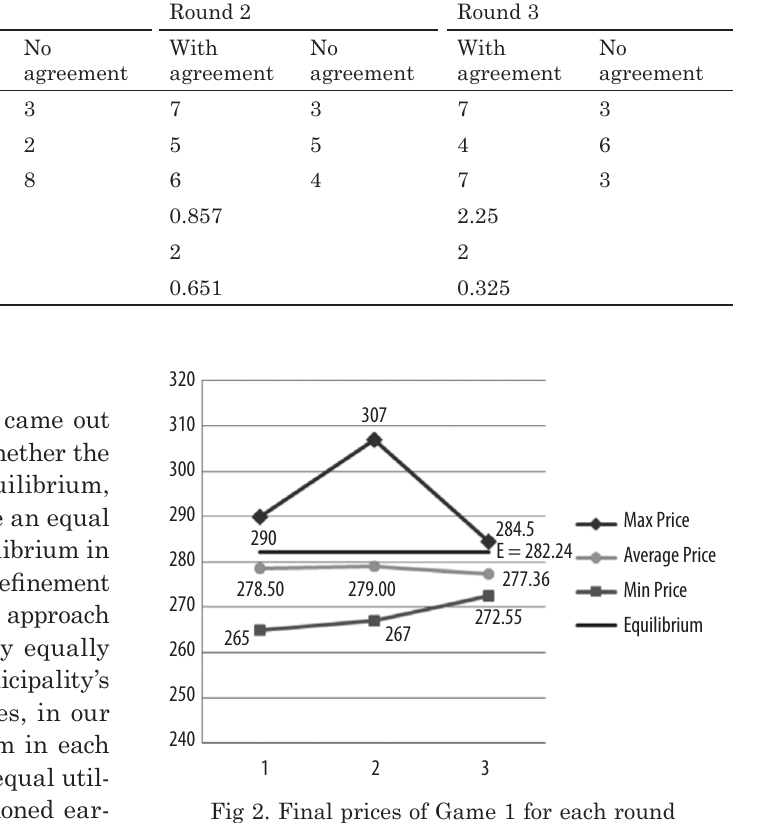
Equilibrium Bargainers’ Dev. prices ( P ) utilities at P E E